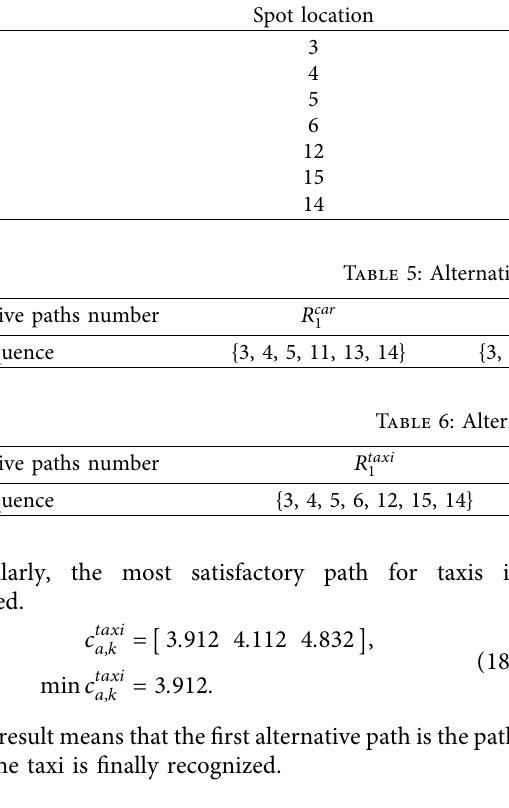
Table 4: Actual travel records of